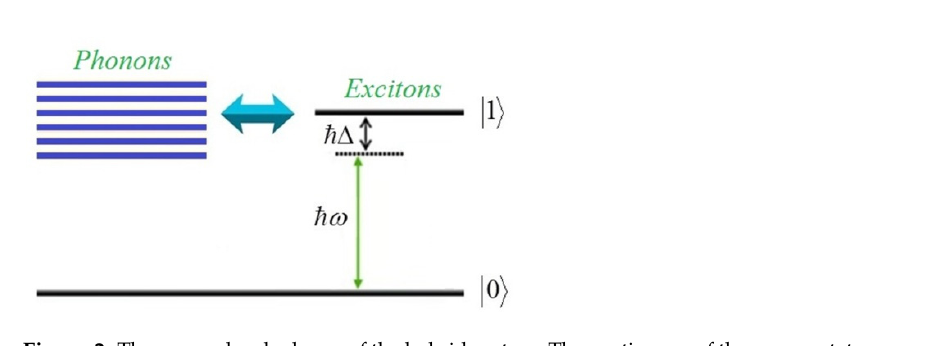
Figure 2. The energy level scheme of the hybrid system. The continuum of the energy states represents the phonon states, while the ground state | 0 (cid:105) and the excited state | 1 (cid:105) describe the two-level excitonic system.